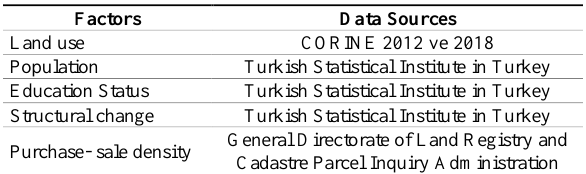
Table 1. Preferred macro factors in the study